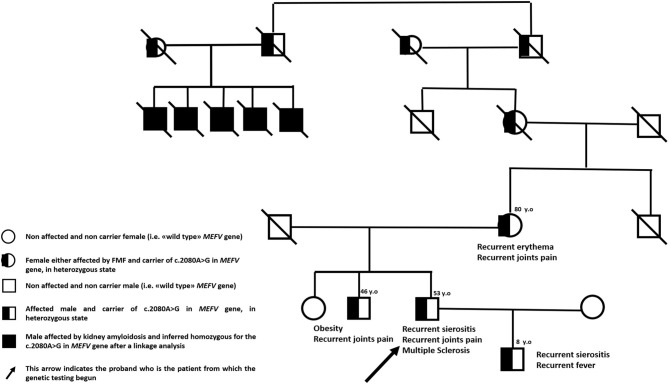
Family pedigree.